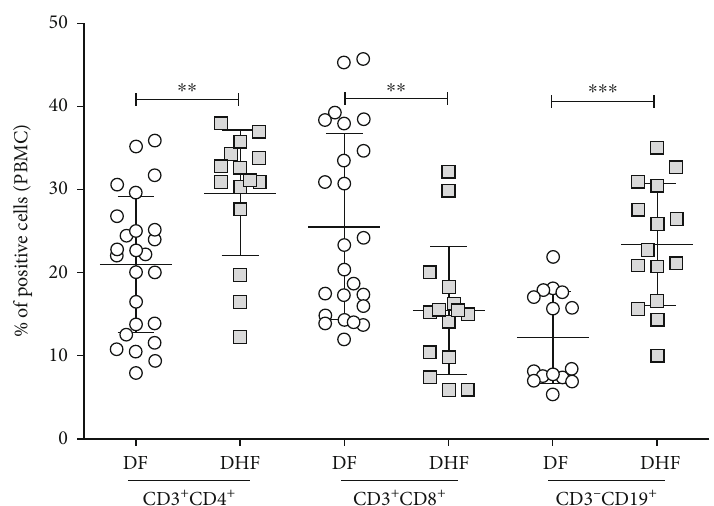
Figure 1: Proportion of CD4 + T cells (CD3 + CD4 + ), cytotoxic T cells (CD3 + CD8 + ), and B cells (CD3 - CD19 + ) determined by fl ow cytometry in ex vivo PBMC of patients with dengue fever (DF) and dengue hemorrhagic fever (DHF). The error bars represent mean ± SD . ∗∗ p < 0 : 01 and ∗∗∗ p < 0 : 001 by the Mann – Whitney U test.